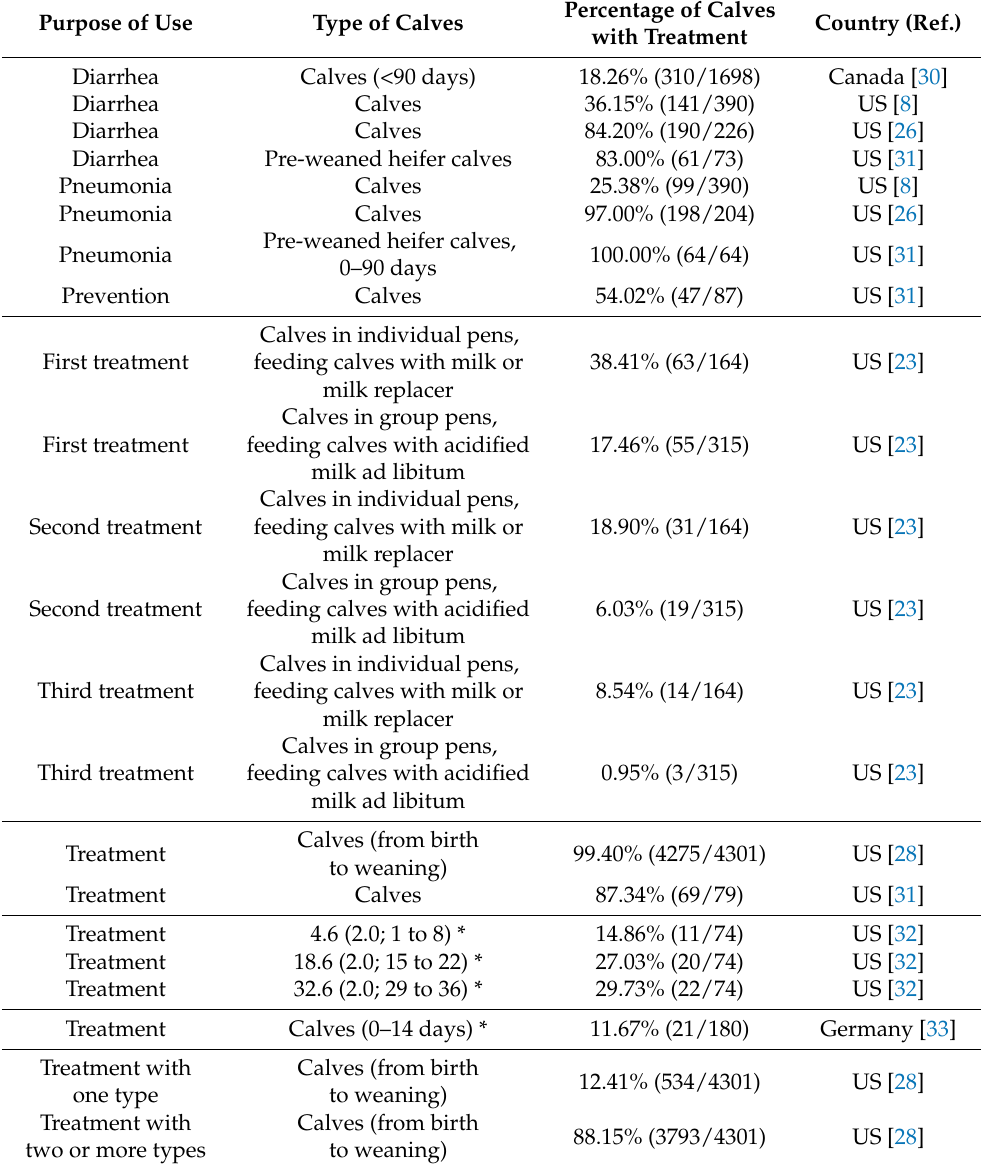
Table 2. Antimicrobial use for different purposes at calf level. Number of calves with treatment divided by the total number of calves on farms in brackets. These data are all from conventional herds. Purpose of Use Type of Calves